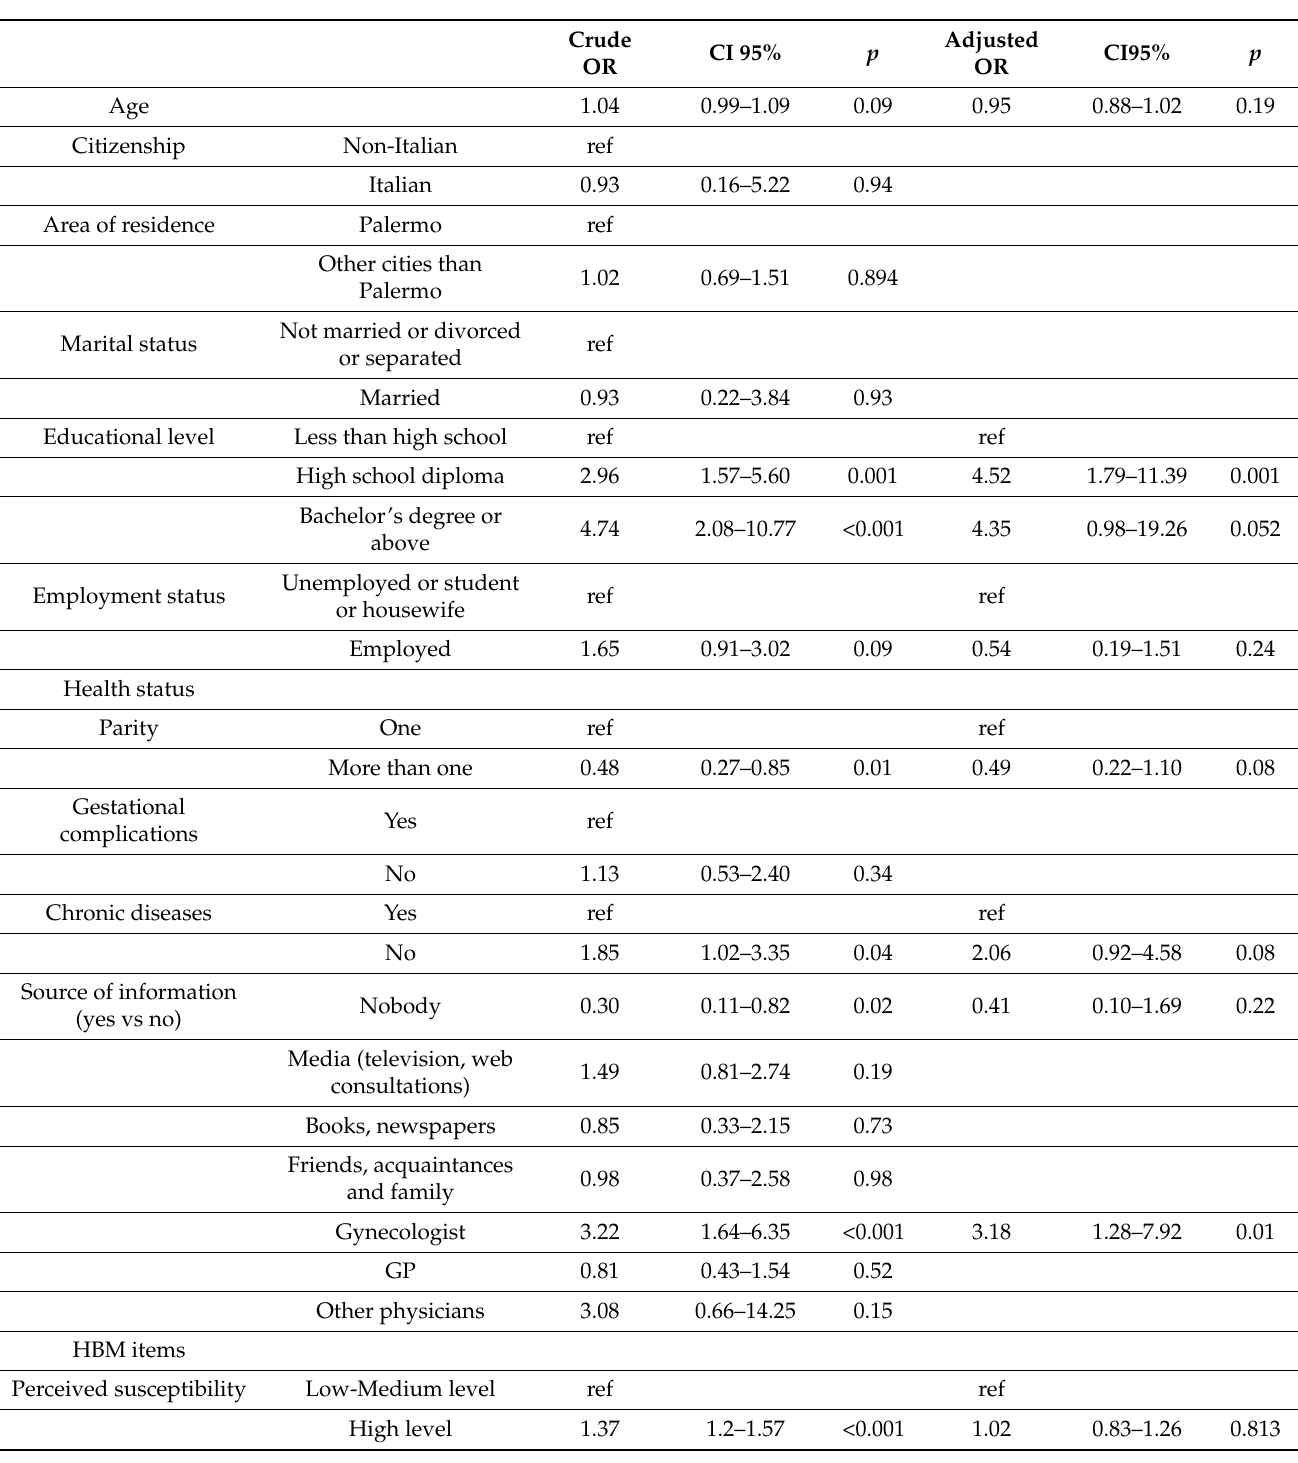
Table 3. Bivariable and multivariable analyses of factors associated with anti-SARS-CoV-2 vaccine acceptance. Crude